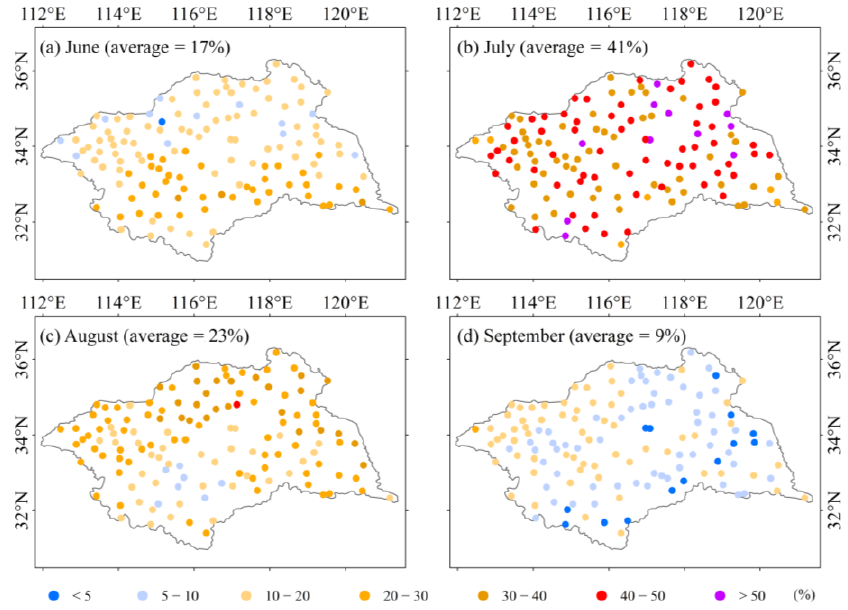
Figure 9. The spatial proportions of the ( a ) June, ( b ) July, ( c ) August, and ( d ) September in which RX5day occurs.